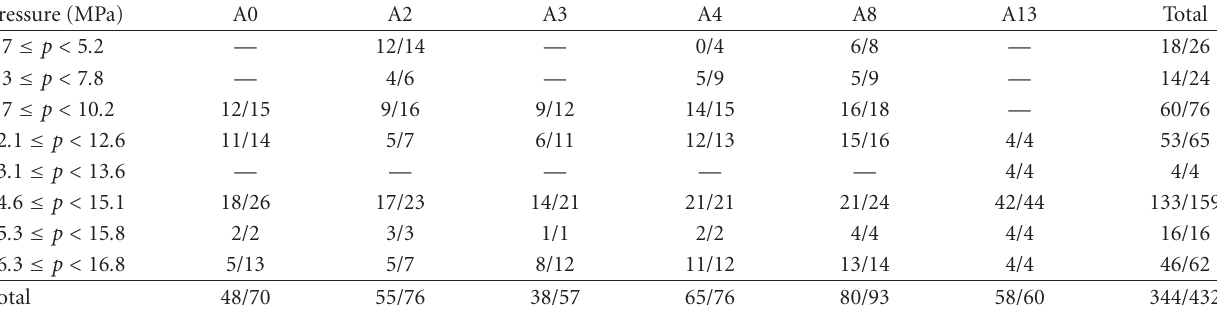
Table 11: Number of cases where ASSERT steady state DNB predictions fell within ± 10% of measured value, arranged by pressure. Pressure (MPa)